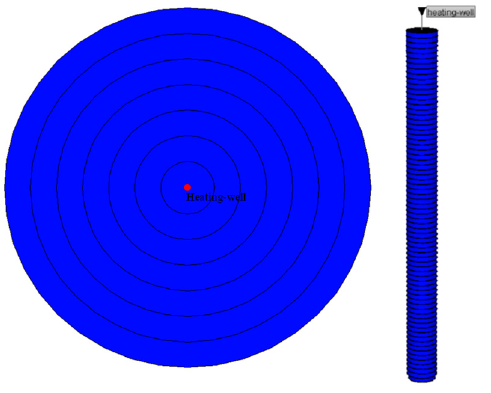
Figure 5. Laboratory-size radial model of electrical heating. Table 1. The numerical simulation parameters of CO 2 , water, and heat-conduction oil.